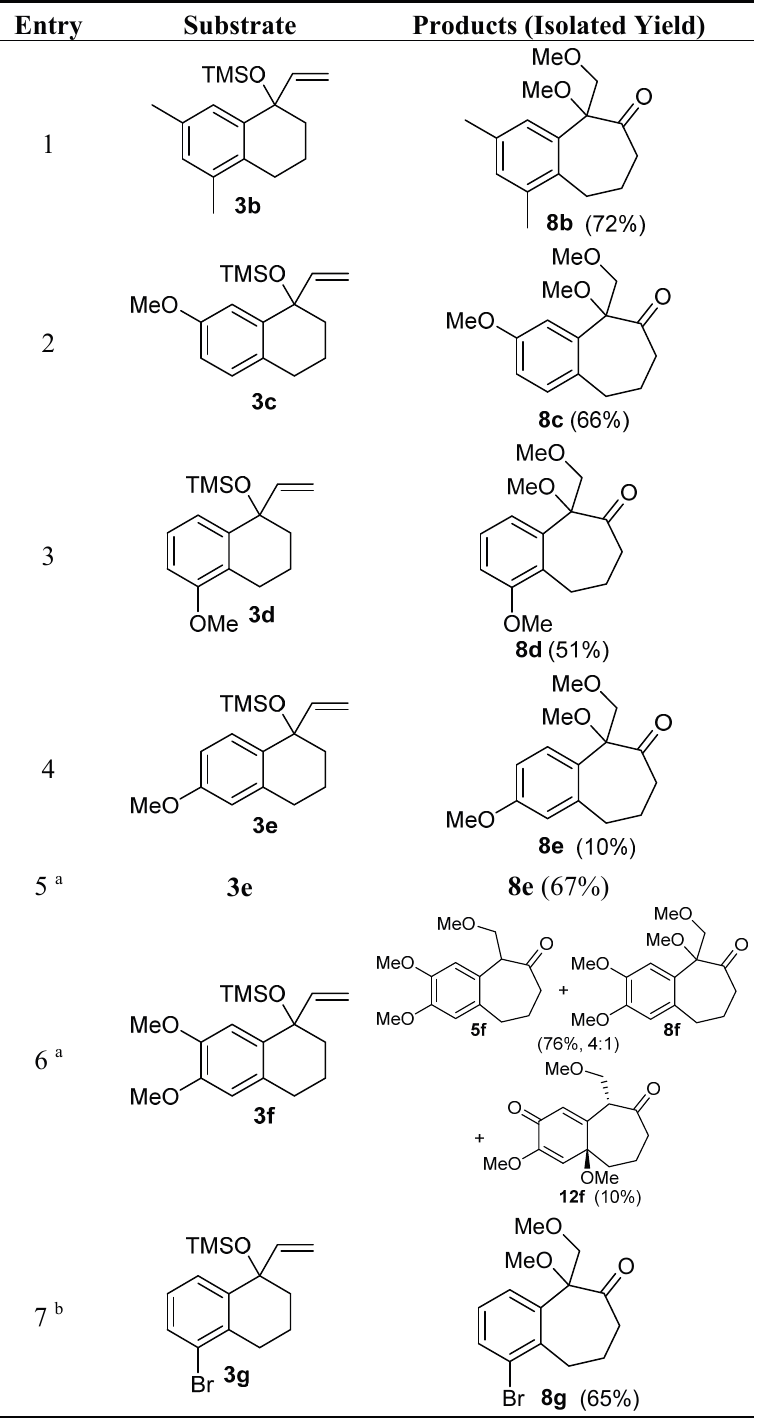
Table 2. HTIB-Promoted Tandem Ring Expansion/Addition in MeOH. HTIB: Entry